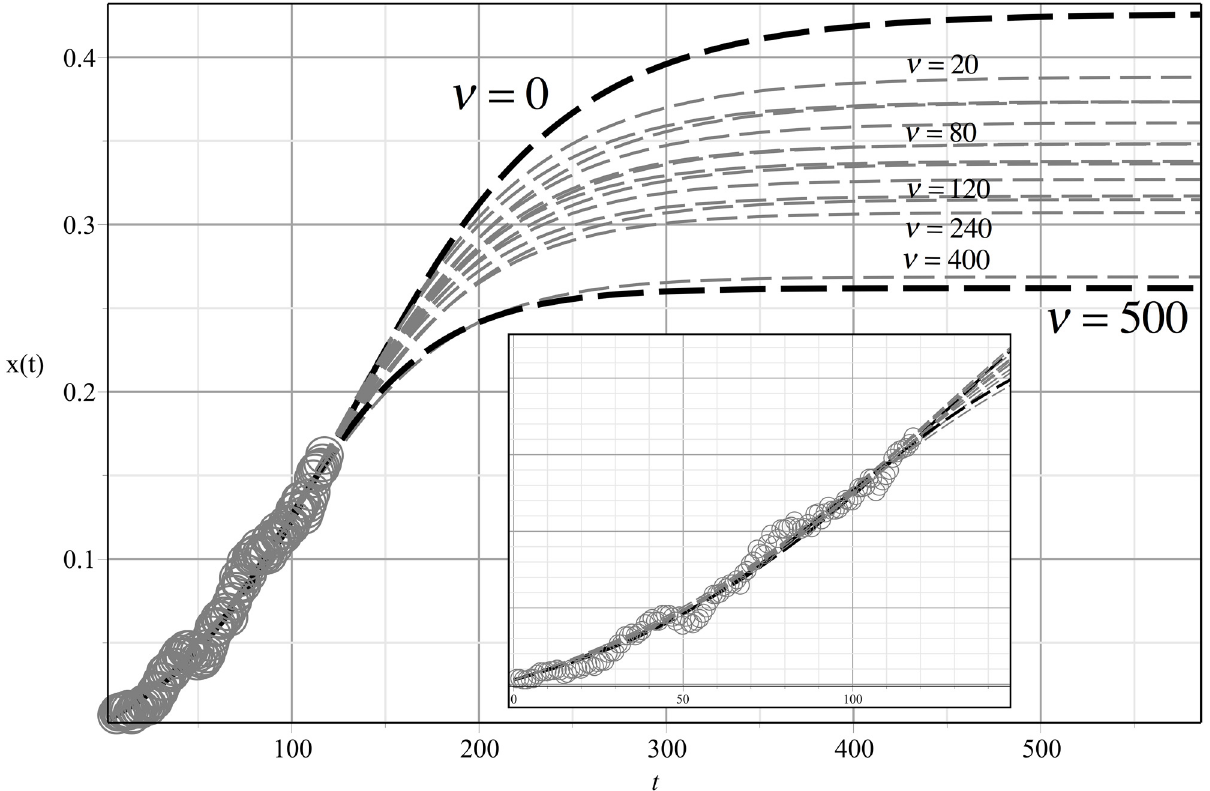
Fig 10. Long term prediction for adoption given by different rewiring rates ν . The fitting of available adoption data is replotted on a finer scale and is given in the inset. Note that increasing the rewiring reduces the adoption.